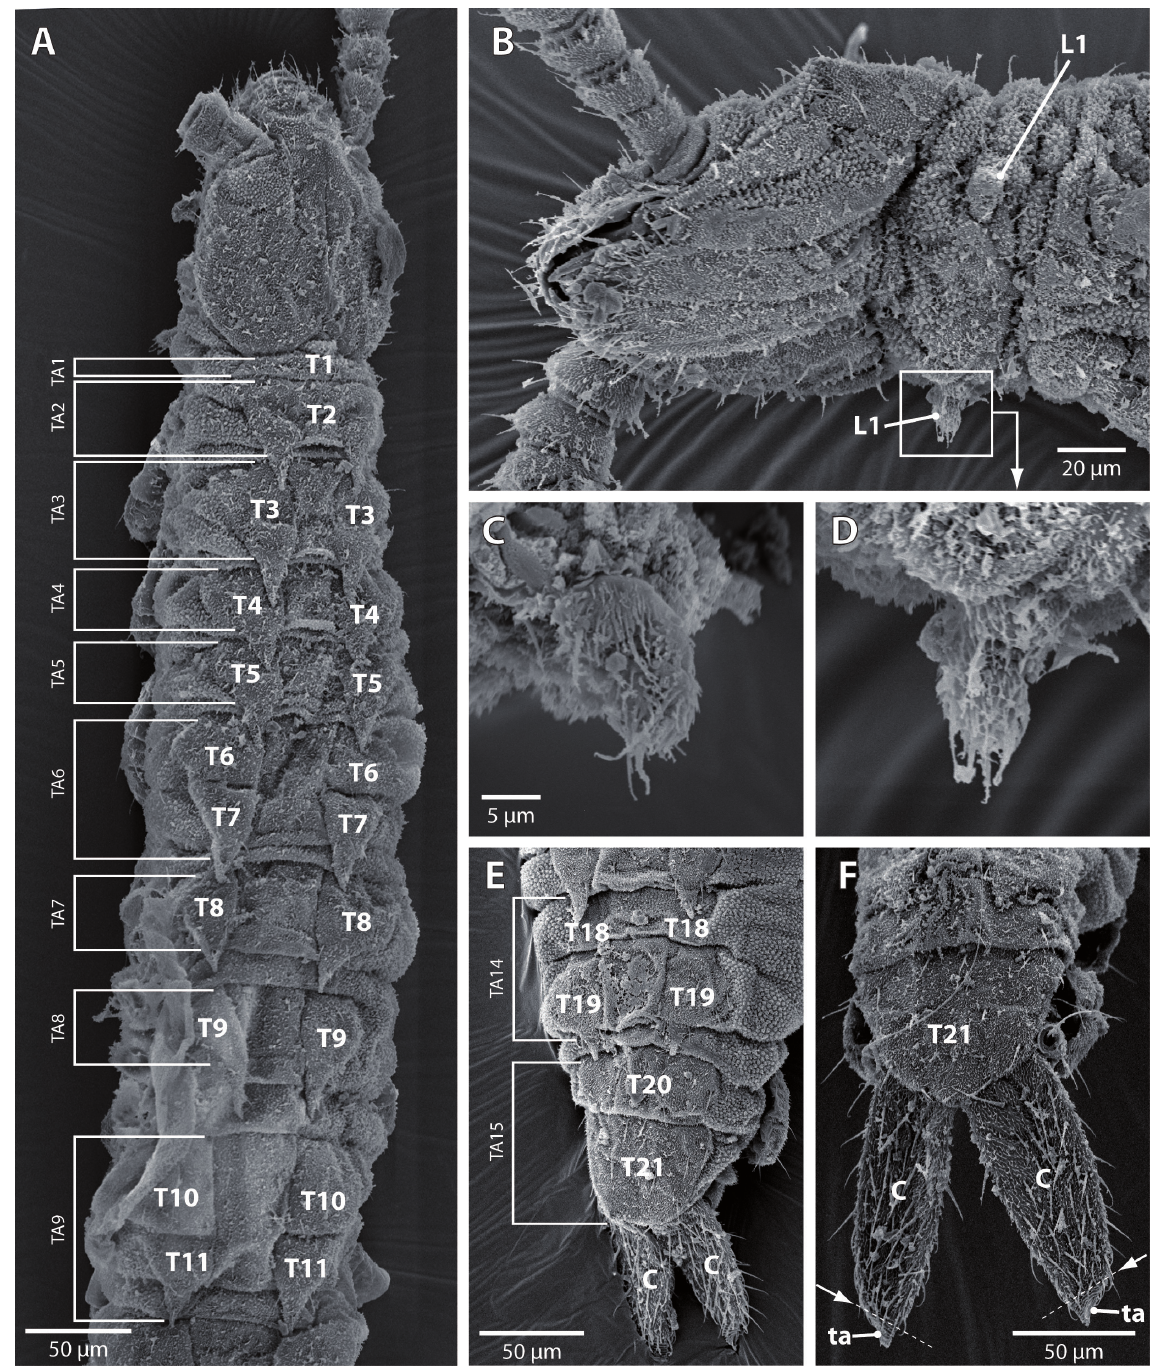
Fig. 8. Remysymphyla hova Aubry & Masson, 1952. Paratypes (MNHN K002) from Ambanja (A-D) and Ambatolampy (E and F), Madagascar. A . Head and anterior half of the trunk, dorsal view. T1-T11, tergites 1-11; TA1-TA9 , tergal areas 1-9 ( fide Domínguez Camacho 2009, fig. 4, page 108). Doubled labeling of tergites shows partial sclerotization. B . Head and first pair of legs, ventral view. C, D . Detail of the first leg of two different specimens. E . Cerci ( C ) last tergal areas ( TA14, TA15 ) ( fide Domínguez Camacho 2009, fig. 4, page 108 ) corresponding to tergites 18-21 ( T18-T21 ), dorsal view. Only exterior parts of tergites 17 and 18 are sclerotized (doubled labeled). F . Last tergite ( T21 ) and cerci ( C ) of other specimen. Arrows , diagonal basis of the terminal areas ( ta